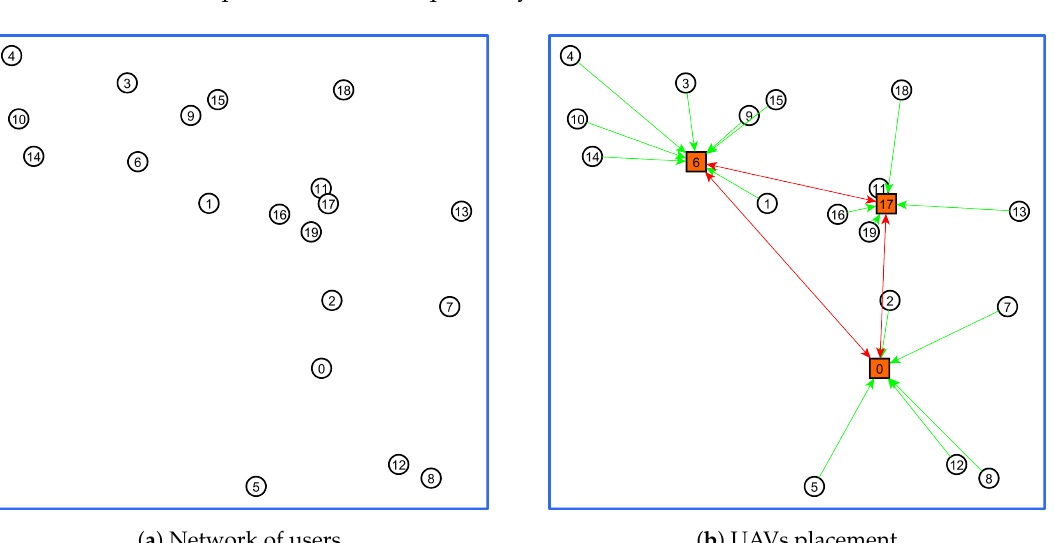
Figure 2. Network with 20 users and the resulting optimal placement of 3 UAVs.